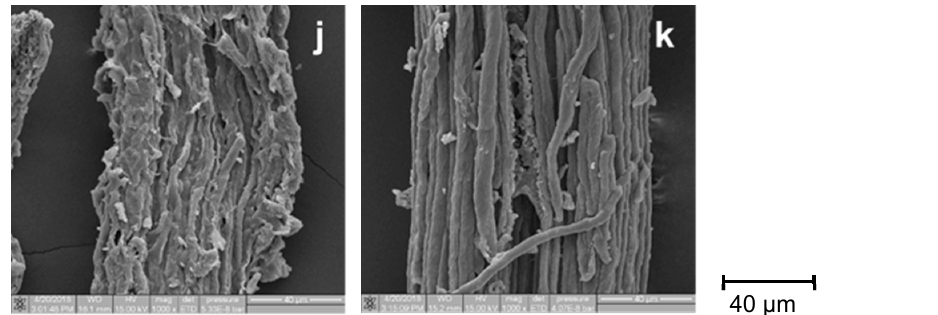
Figure 4. SEM images of ( a ) palm bunch, ( b ) cellulose-p-0, ( c ) cellulose-p-10, ( d ) cellulose-p-20, ( e ) cellulose-p-30, ( f ) cellulose-p-40, ( g ) CMCp-0, ( h ) CMCp-10, ( i ) CMCp-20, ( j ) CMCp-30, and ( k ) CMCp-40. Abbreviations: SEM, scanning electron microscope.